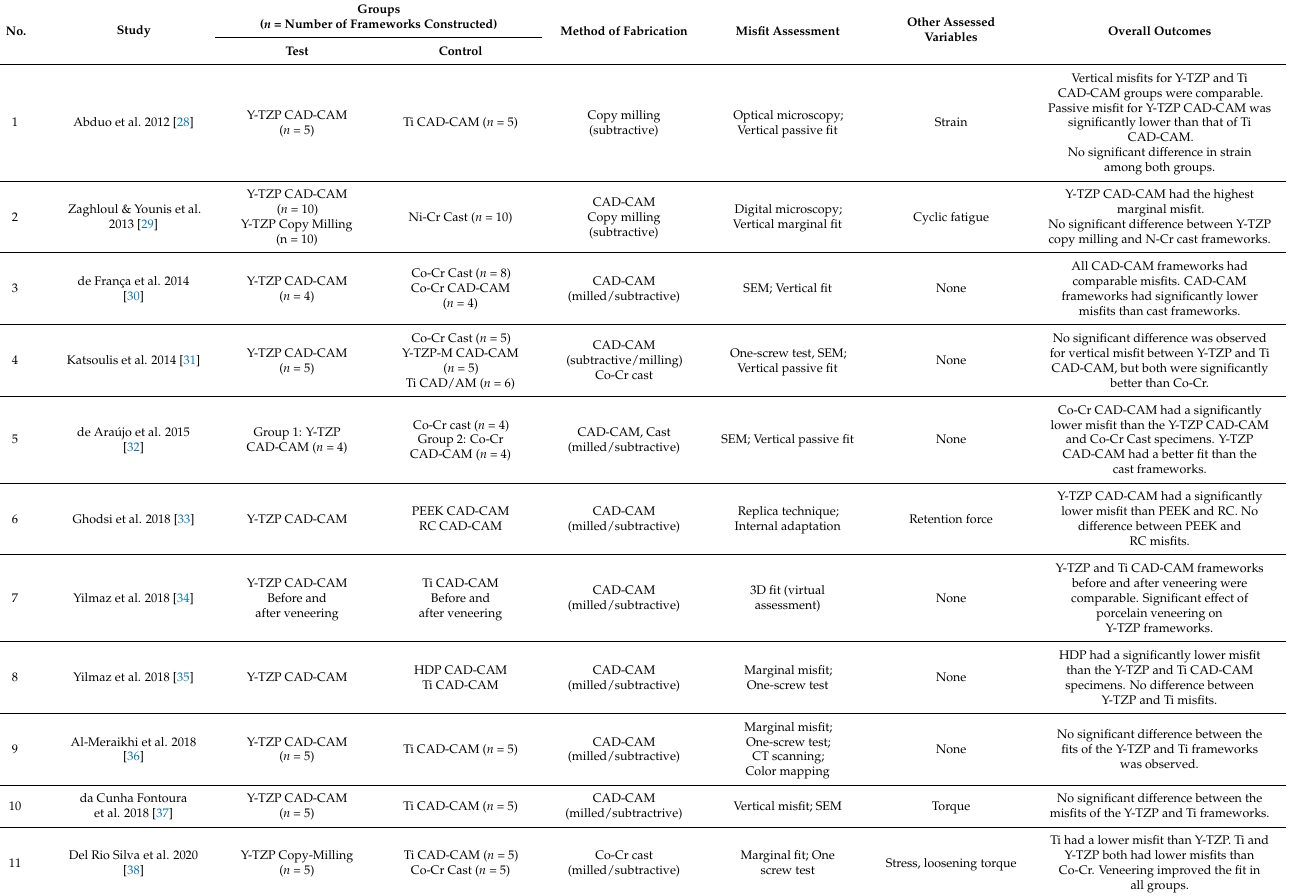
Table 1. General characteristics and the overall outcomes of the studies